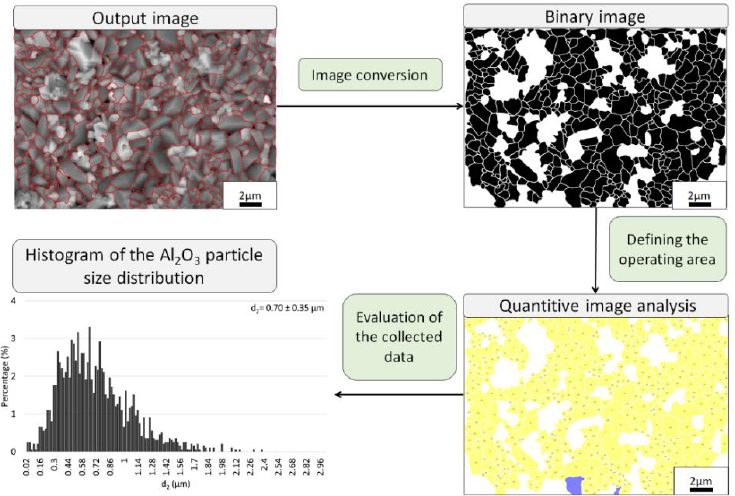
Figure 1. Schematic of the image processing methodology used to obtain the Al 2 O 3 percentage share of the particle size distribution in the samples.